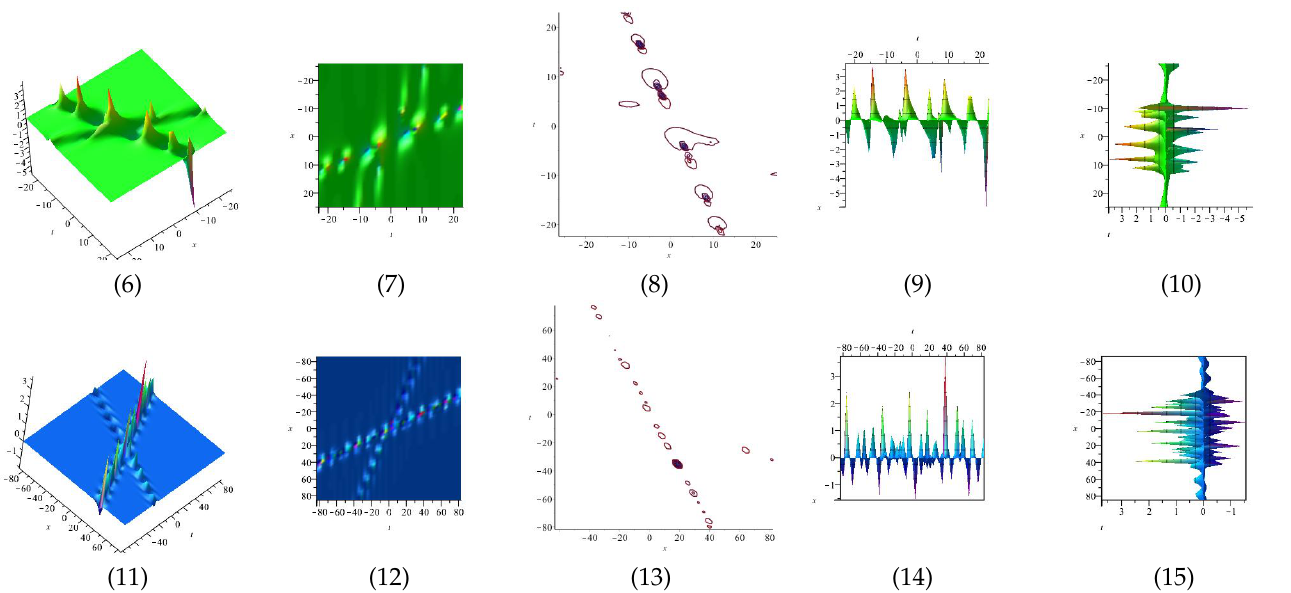
Figure 14. The 3D and 2D with the diagram of the imaginary part of equation u 3,1 , in three different